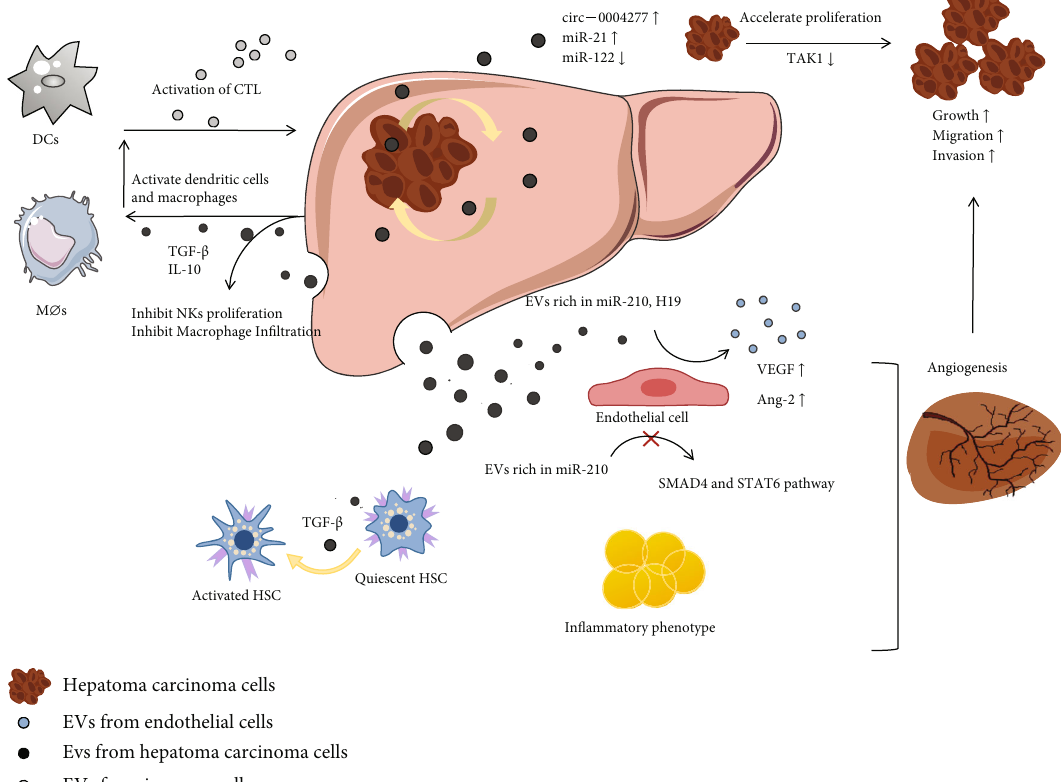
Figure 5: The detailed mechanism of exosomes in hepatocellular carcinoma (HCC). Hepatoma carcinoma cells in fl uence neighboring cells through exosomes and established tumorigenic microenvironment. On one hand, cancer cell-derived exosomes promote di ff usion of tumor contents to normal cells, promote epithelial-mesenchymal transformation and tumor angiogenesis, and promote stellate cell activation that is related to liver fi brosis pathway. On the other hand, cancer cell-derived exosomes could present and deliver relevant information to activate the immune responses of the body or inhibit immune cell function to promote tumor